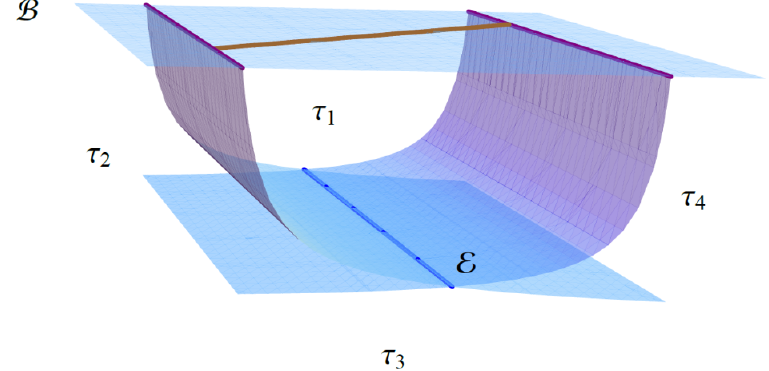
Figure 5 . This (cid:12)gure shows the causal decomposition of the bulk M and the boundary B . The two surfaces that intersect at E are N (cid:6) and the brown line is the boundary interval A